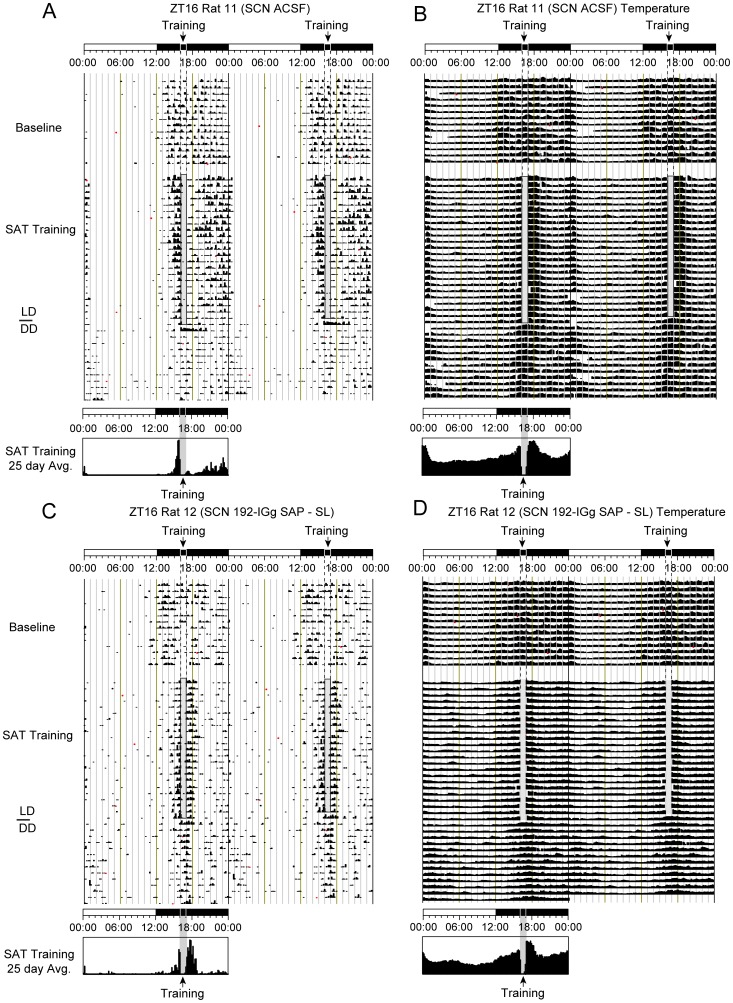
Representative 48 hour double-plotted running wheel actogram and temperature record for ACSF (A&B) or 192 IgG-saporin infused animals (C&D) training on the SAT at ZT16.SAT training is relative to the topmost LD bar (where dark bar = lights-off). The shaded column represents the task training period where daily water is available including the approximate 40 min SAT session in which animals are absent from their home cages and the 20 minute free water period that follows training. The last day of training corresponded to the final day of LD conditions. The first 14 days represent baseline activity of animals with ACSF or saporin infusions into the SCN prior to SAT training. The second portion of the actogram illustrates the final 25 days of training of SAT training and the subsequent period of constant conditions (DD). Time histograms below provide averages of running wheel activity for the final 25 days of training shown above on a 24-hour scale. Shaded column represents time of training. (
A
) Double-plotted actogram and (
B
) temperature record of ZT16 animal with ACSF infusions. Note that animal shows a robust increase in activity prior to daily training. (
C
) Actogram and (
D
) temperature record of ZT16 animal with 192 IgG-saporin infusions into the SCN. Daily anticipation for task training is reduced relative to control animals with the greatest activity coinciding with the period after the animal returns from training.